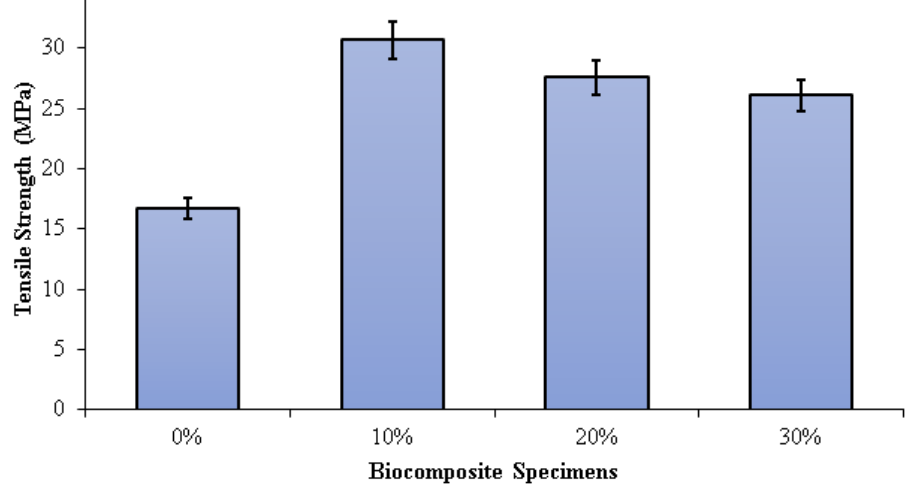
Figure 6. Tensile strength of PLA/PCL/nHA biocomposite specimens.